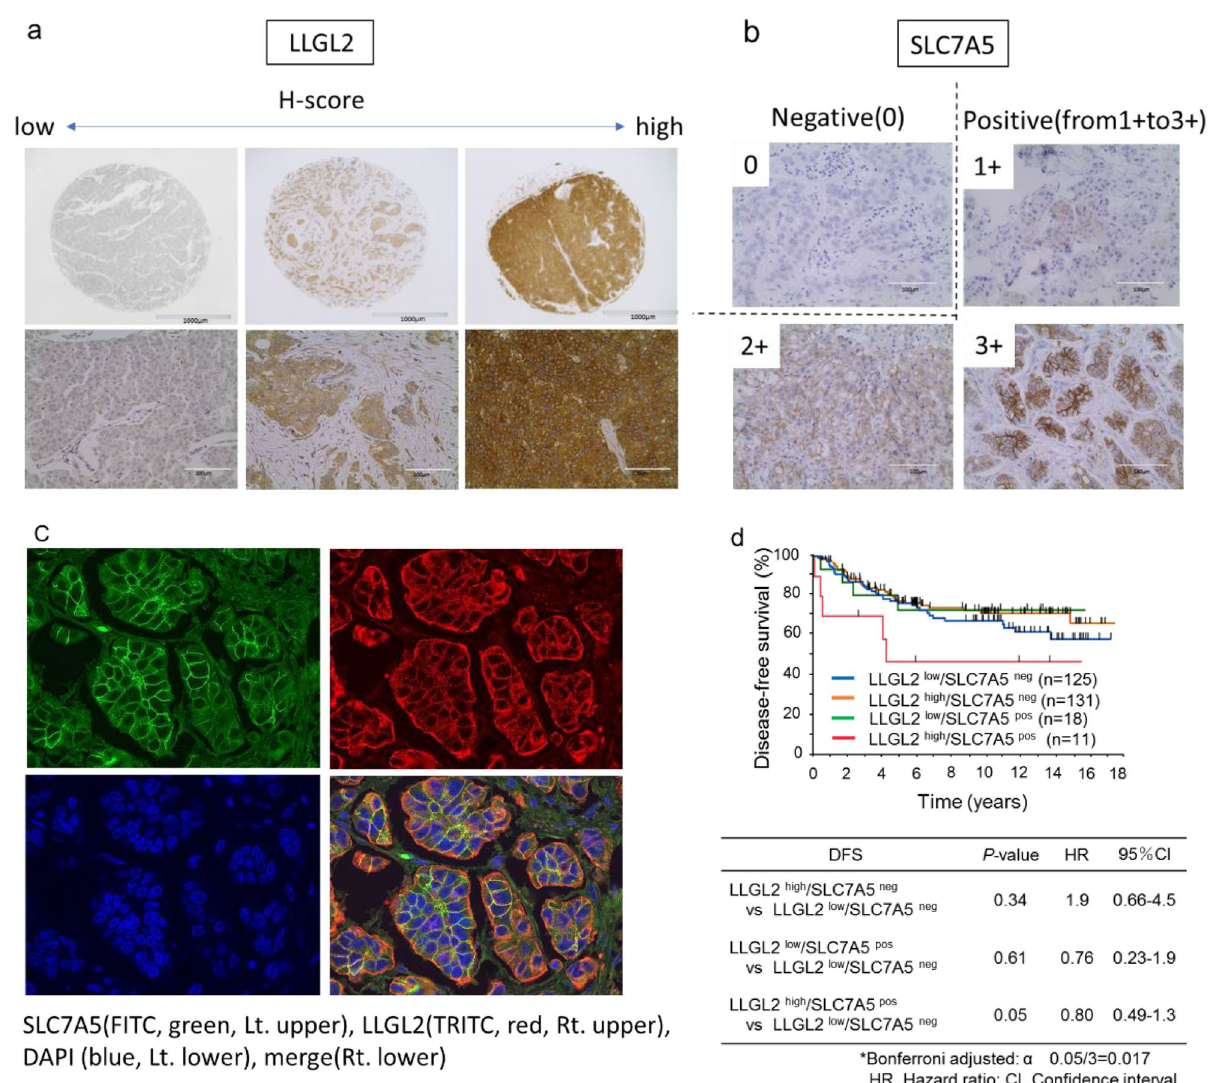
Figure 3. Representative images of LLGL2 protein expression in breast cancer tissues. H-score: 0, 90, and 270 from the left ( a ). Representative images of SLC7A5 protein expression in breast cancer tissues. 0 is negative and 1+ to 3+ is positive ( b ). Immunofluorescence staining for LLGL2 and SLC7A5. SLC7A5 (FITC, green, lt. upper), LLGL2 (TRITC, red, rt. upper), DAPI (blue, lt. lower), and merge (rt. lower) ( c ). Kaplan–Meier survival curves of DFS according to the combination of LLGL2 and SLC7A5 protein expression ( d